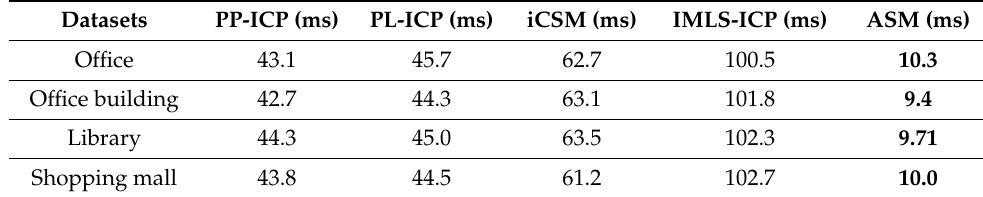
Table 2. Computation time statistics